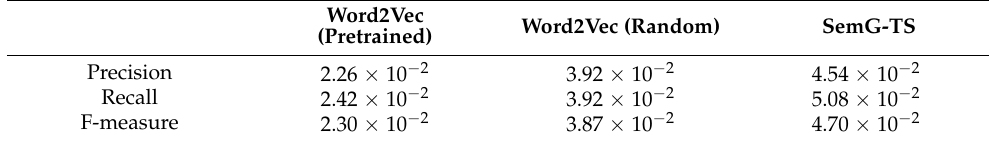
Table 10. Automatic evaluation using